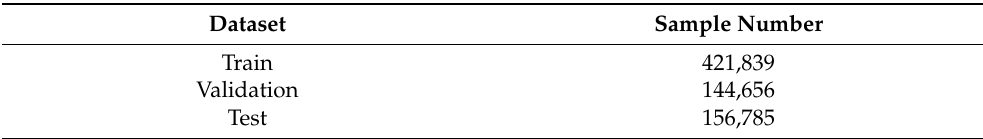
Table 1. The number of image samples in the train, validation, and test datasets. In the table, the second row denotes the sample number of the train dataset, and the third and fourth rows present the sample numbers of validation and test datasets, respectively.